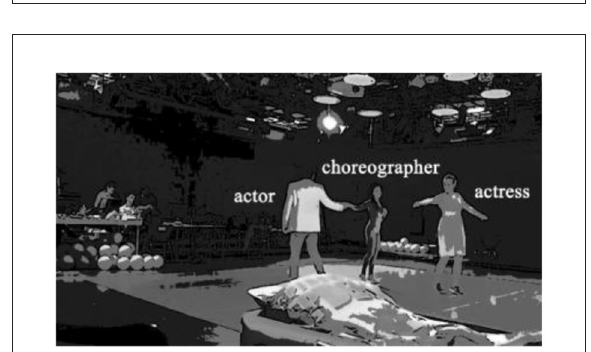
FIGURE2.3 Movement trajectories of CHO, ACF, and ACM during the dance (line